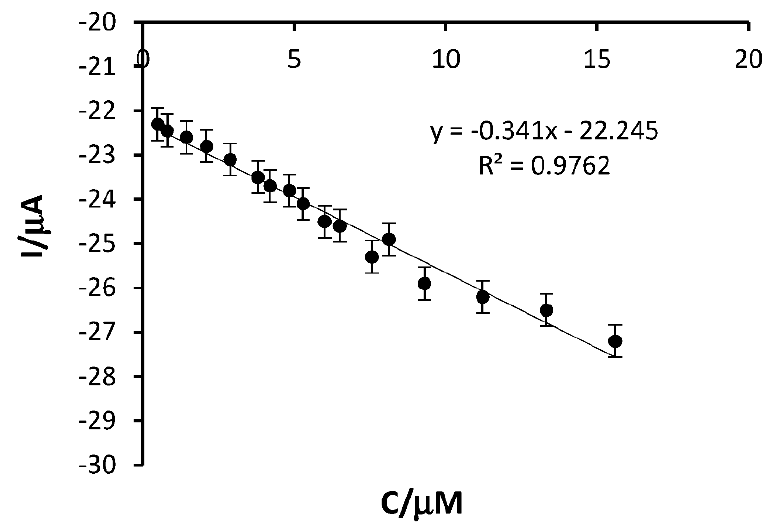
Figure 10. Linear fit of SPE-SWCNT-Ty response in the concentration range 0.49–15.602 µM. Using the calibration curve values, I max was determined and then graphically rep- resented as log( I /( I max − I )) vs. log(HT). From the line equation, the Hill coefficient ( h ) was extracted and represented by the slope of the line. SPE-SWCNT-Ty showed a Hill coefficient with a value near 1, which means that the overall process at the biosensor surface exhibits Michaelis–Menten kinetics. An obtained value of h lower than 1 reflects a negative cooperative effect between occupied active zones on the SPE-SWCNT-Ty surface. Next, the Table 3. Linear dependence equation, R 2 , LOD and LOQ for the two modified electrodes. Lineweaver–Burk equation was used to calculate the Michaelis–Menten constant.